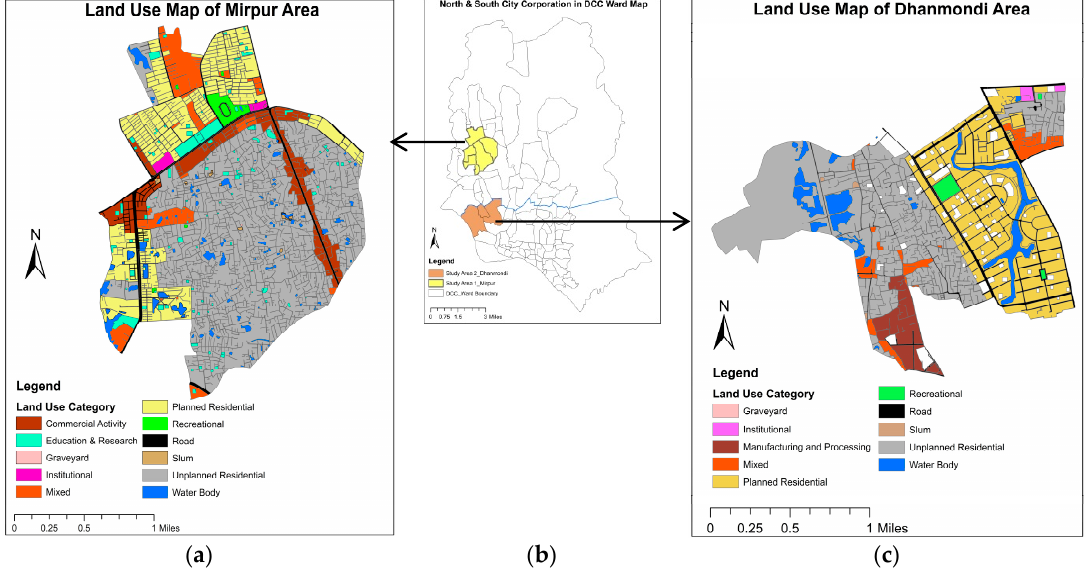
Figure 2. ( a ) Land-use map of study subarea, Mirpur; ( b ) Ward map of Dhaka city showing the two study subareas; and ( c ) Land-use map of study subarea, Dhanmondi (Source: Capital Development Authority, Dhaka; GIS Database, 2010).